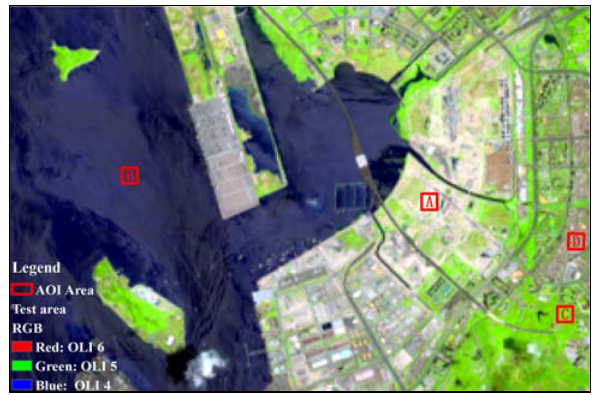
Figure 3. The false color image (R(6)G(5)B(4)) of test area A comparison between the TCB and the NDBaI 1-7 maps are Aug. 9, 2013. TCB (Figure 4 (a)) NDBaI 1 (Figure 4(b)),